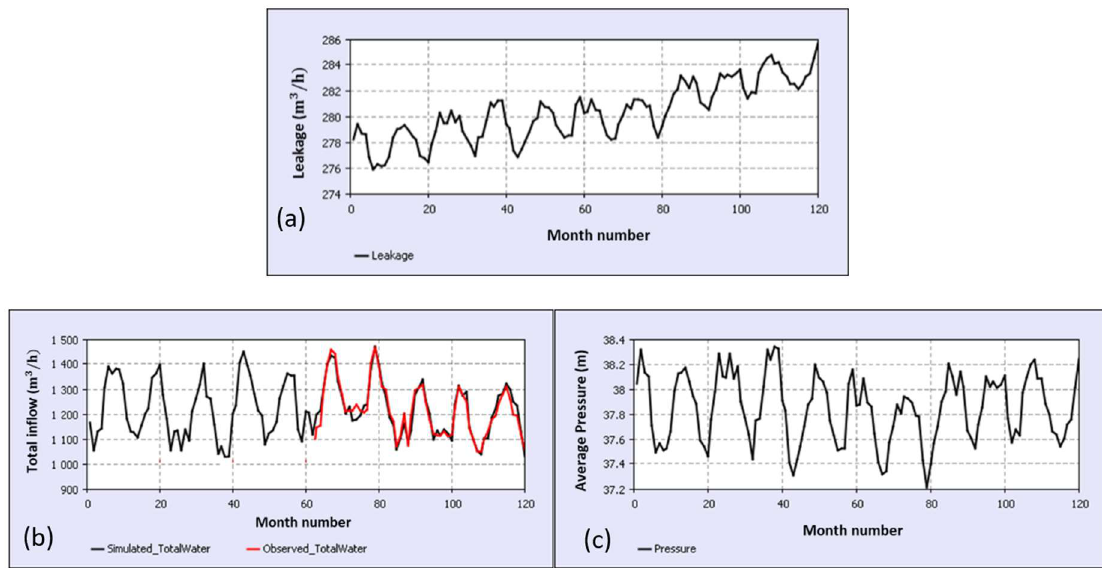
Figure 9. Evaluation of the WDN during the simulation time (2007–2016): ( a ) Simulated leakage; ( b ) Total inflow; ( c ) Average